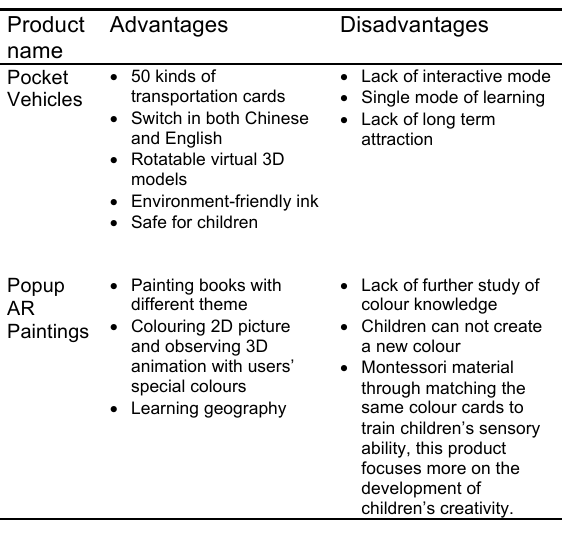
Table 1. The existing products